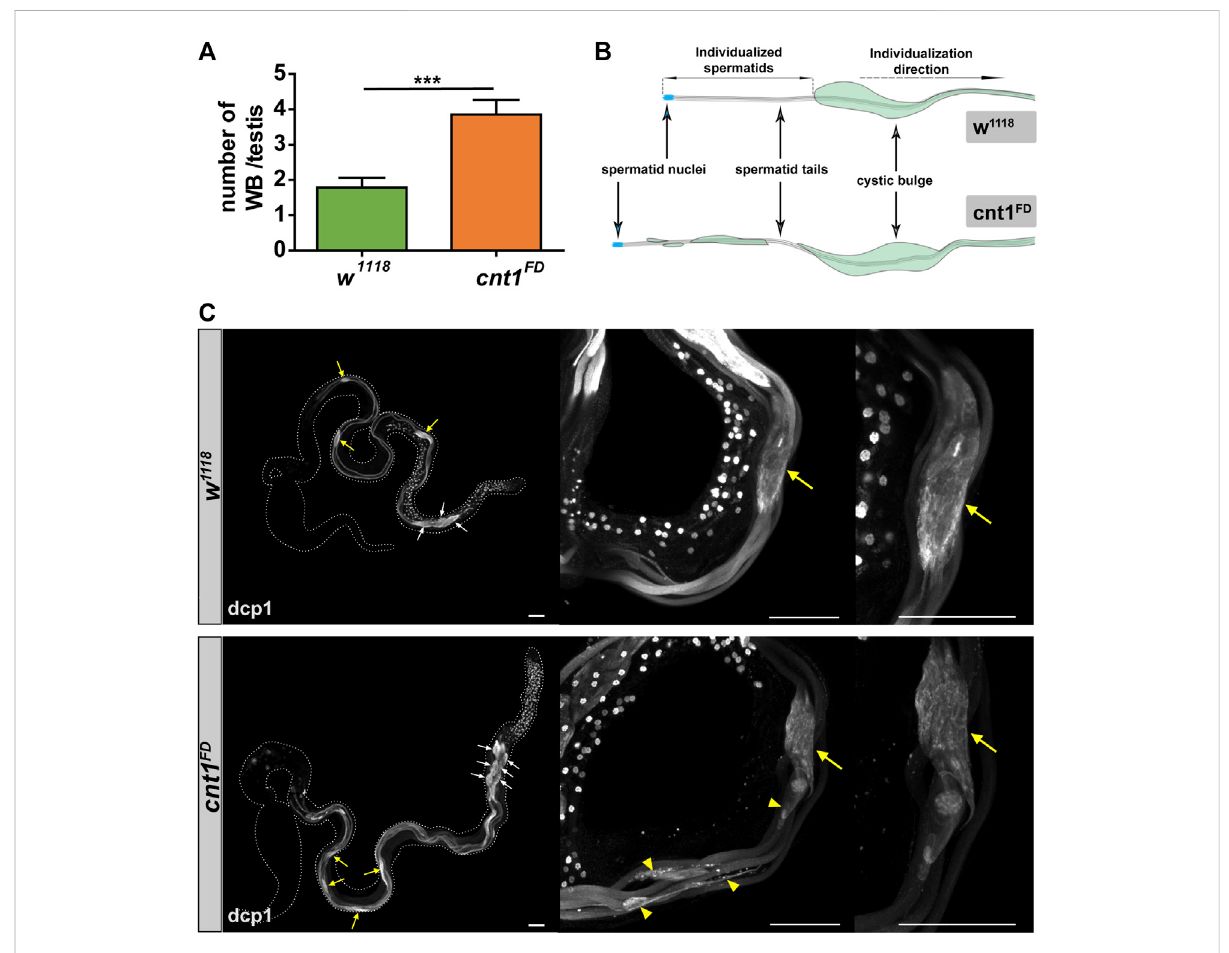
FIGURE 6 Cnt1 mutation impairs spermatid maturation during the spermatid individualization process. (A) Number of waste bags in w 1118 and cnt1 FD strains. Signi fi cance wasanalyzed usingone-tailedStudent ’ st-test and labeled as follows: *** p < 0.001; n ≥ 10. Error barsare shown as mean ± SEM. (B) Illustration of the distorted shape of the cystic bulge in cnt1 FD compared with w 1118 . (C) Testis staining with death caspase-1 antibody (white). Dcp1 signal is absent in the individualized part of the cyst in w 1118 , whereas it is present in cnt1 mutants (yellow arrowhead). The yellow arrows point to the cystic bulges, while the white arrows point to the waste bags. Scale bar: 50